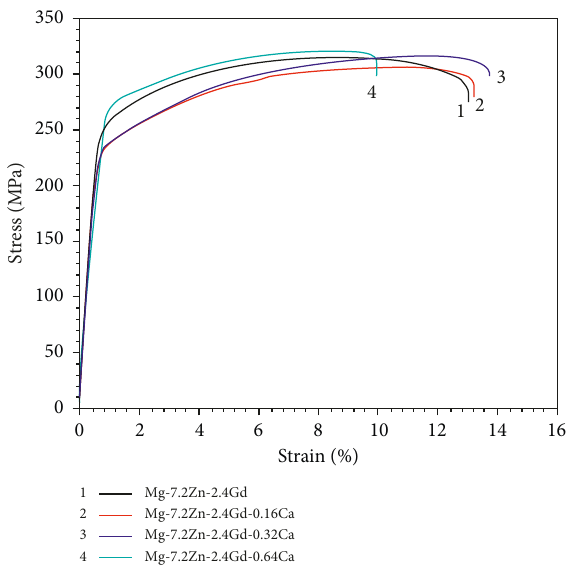
Figure 6: Stress-strain curves at room temperature of the as-ex- truded Mg-Zn-Gd(-Ca)